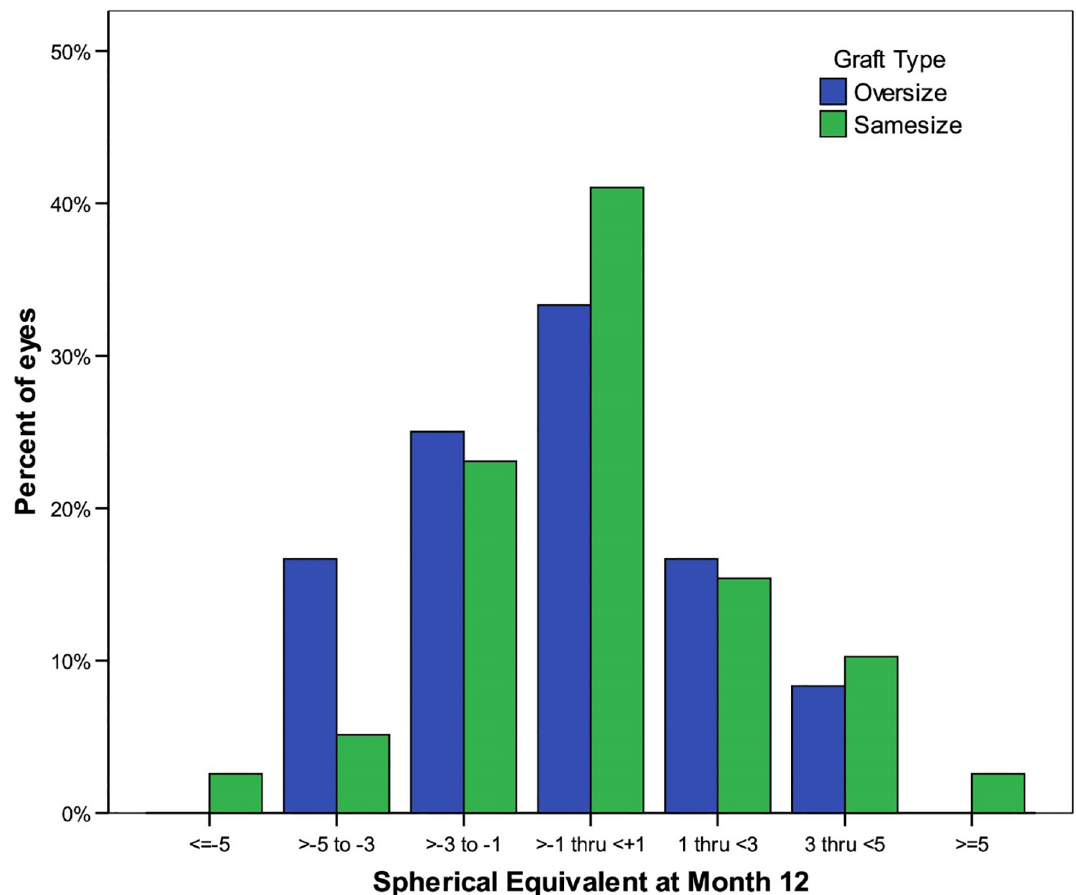
Fig 1. Spherical equivalence in diopters of refraction at 12